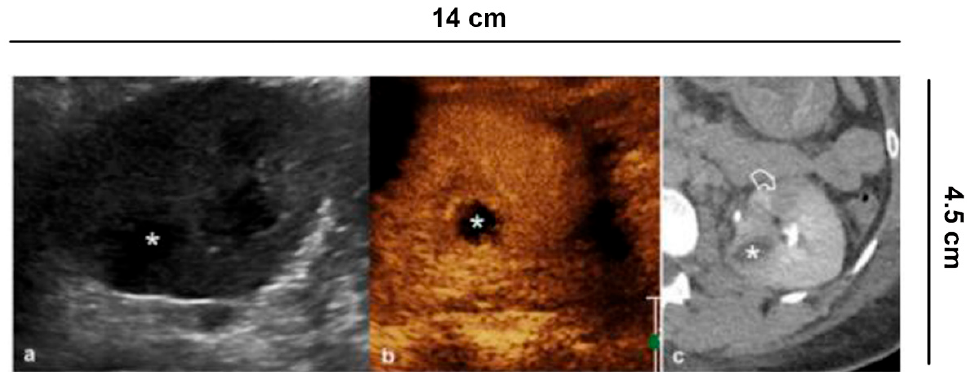
Figure 6. Ablative technique follow-up. ( a ) Before the cryo-ablative treatment, CEUS shows an iso-vascular, partially exophytic lesion at the upper pole of the right kidney (curved arrow). After treatment, CEUS shows diffuse and persistent intralesional vascularization (arrowheads) to 24 h ( b ); at 7 ( c ) and 14 days ( d ) there is a progressive reduction of vascularity; after one month ( e ) the lesion appears completely avascular, a sign of a successful treatment.